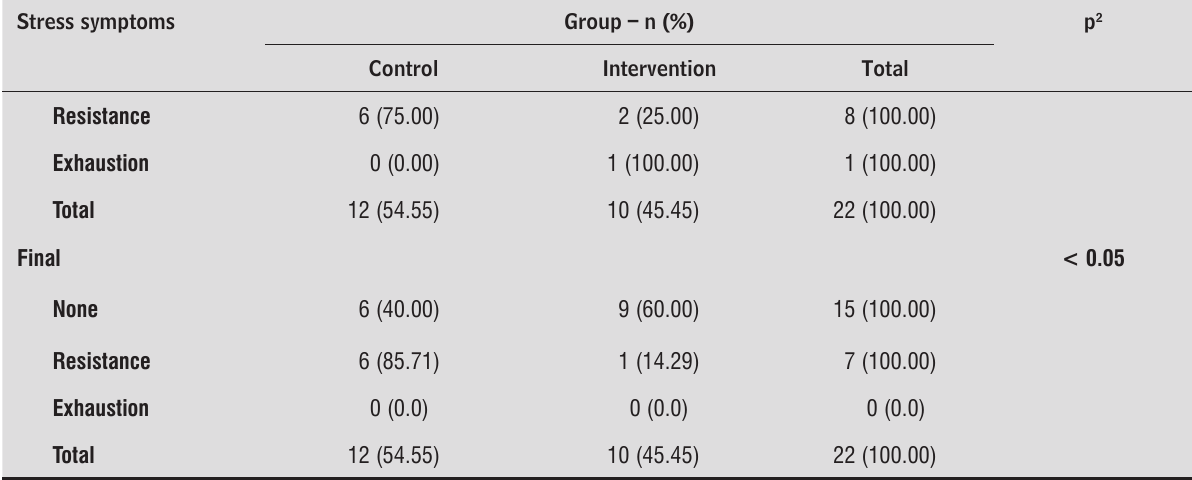
Table 2 - Distribution of number of occurrences (n) of the stress symptoms in percentages according groups Stress symptoms Group – n ( % ) p 2 Control Intervention Total Resistance 6 (75.00)